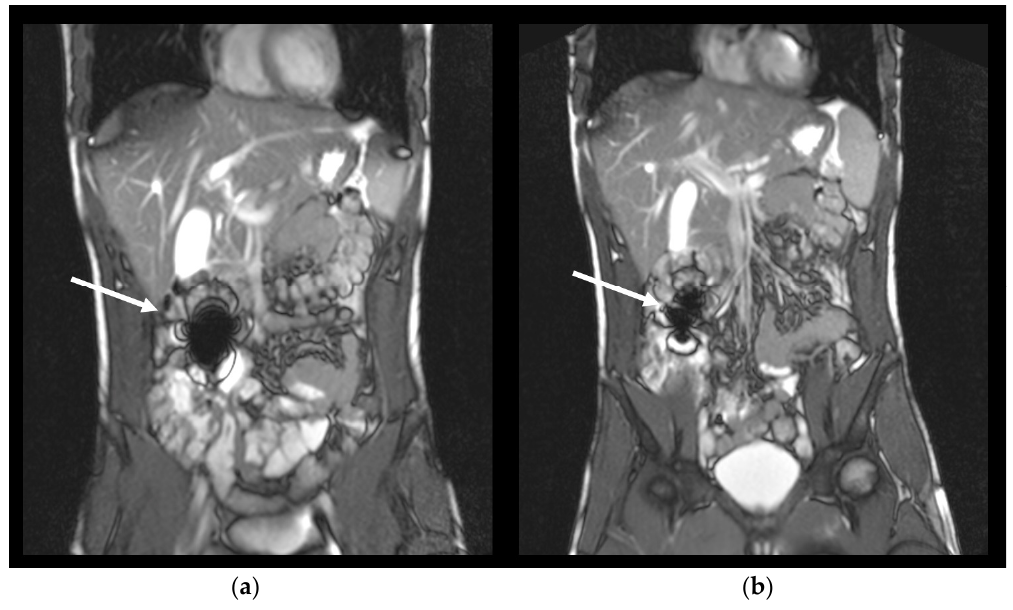
Figure 1. Exemplary coronal images of one volunteer with an intact capsule represented by an intact susceptibility artefact of iron oxide at 75 min after capsule ingestion in the small intestine ( a ), and the same artefact after disintegration of the capsule at 90 min ( b ). Arrows show the respective artefact.